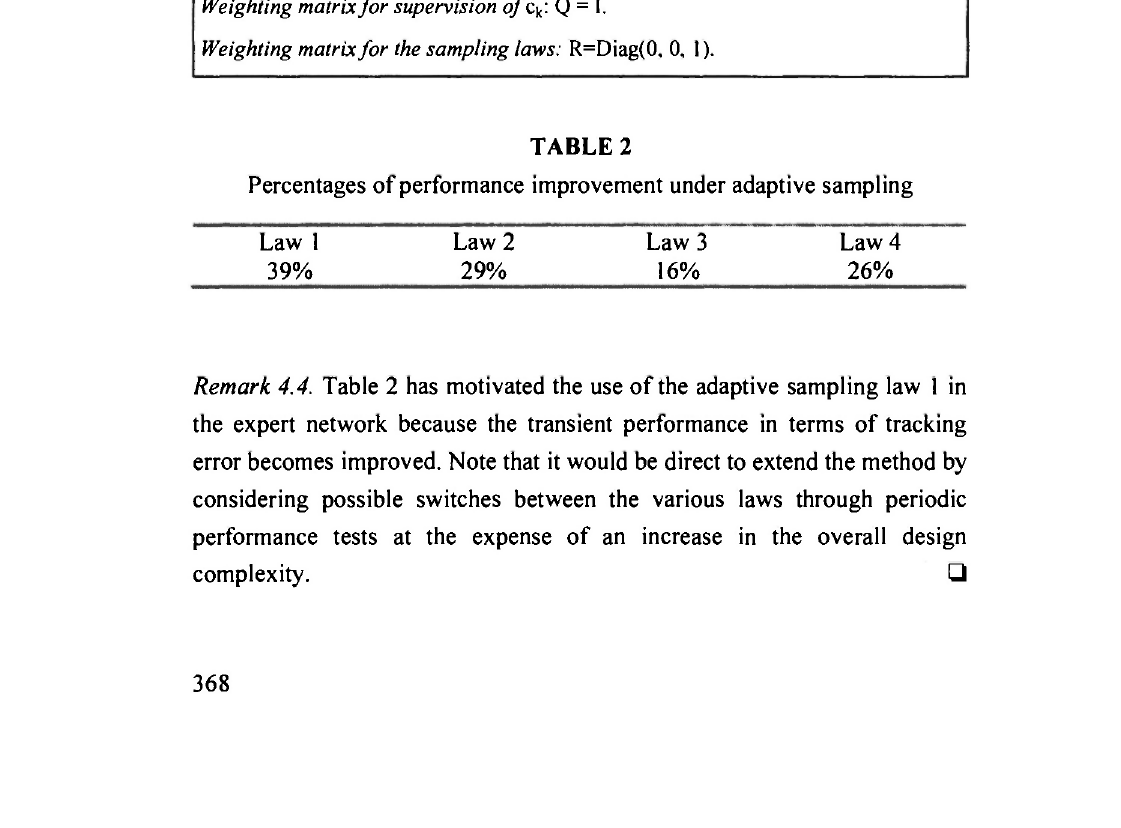
Percentages of performance improvement under adaptive